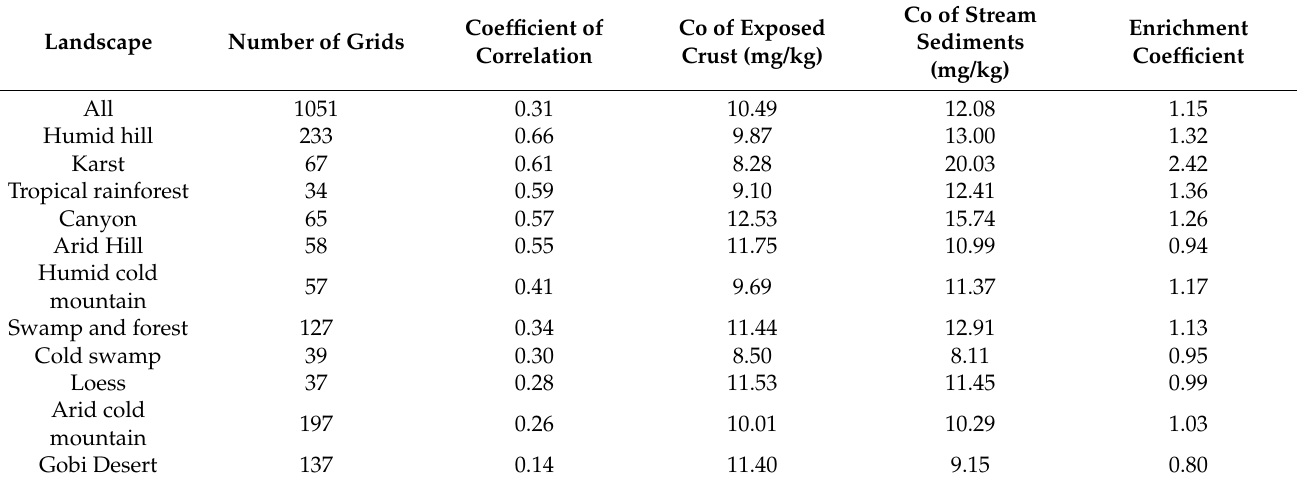
Figure 9. Map of RGNR extent and landscapes across China (Distribution of landscape was redrawn by Guo et al. [66]). Table 4. Grid-based data correlation and statistical characteristics of cobalt. The data of stream sediments was obtained from Xie et al.